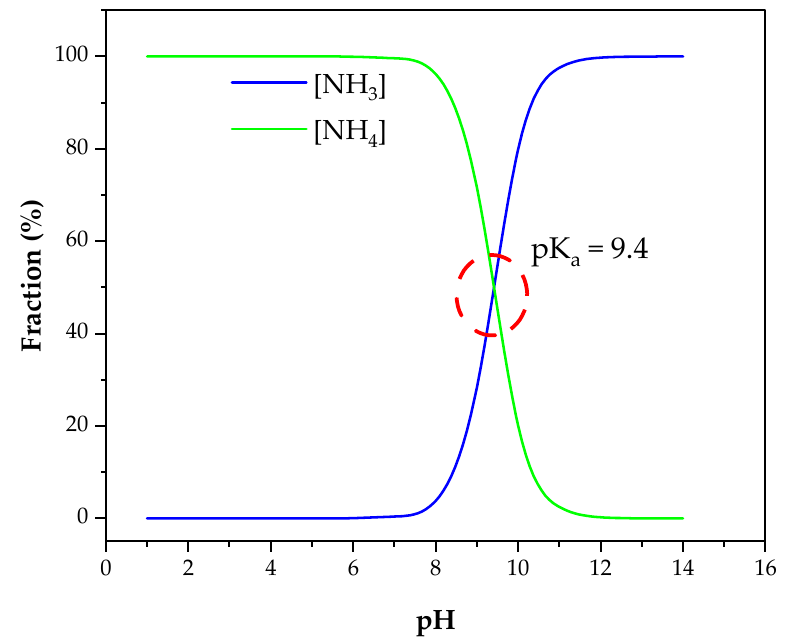
Figure 8. Ammonia/Ammonium speciation based on pH level at 20 °C.